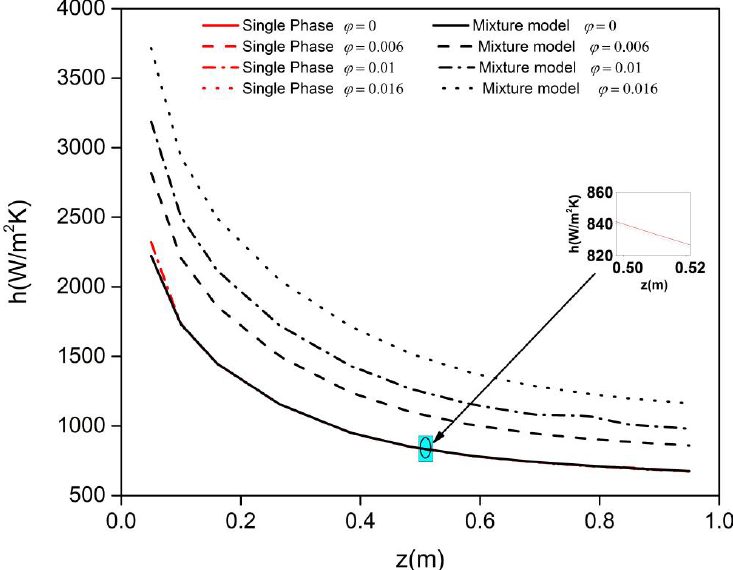
Figure 5. Local heat transfer coefficient obtained for Re = 1600, d np = 42 nm, and Al 2 O 3 -water based nanofluids: comparison between the single-phase and mixture models with temperature-dependent properties.